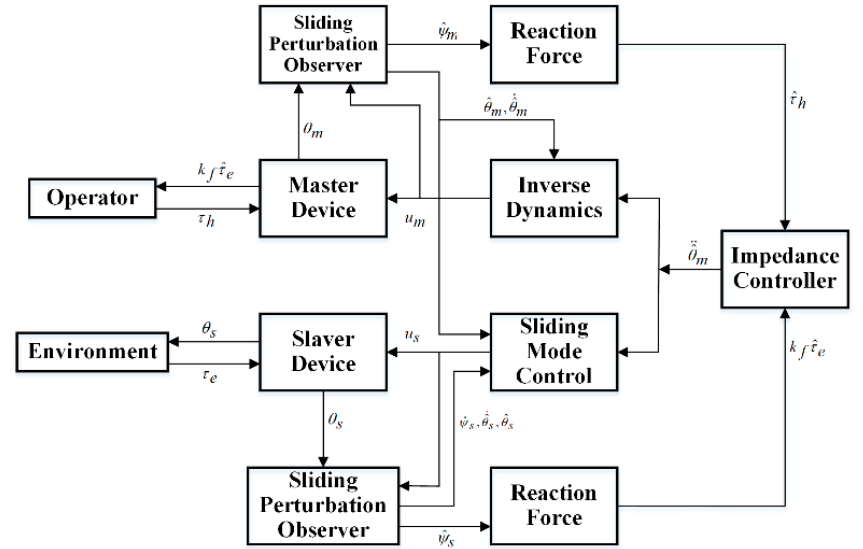
Figure 5. The work flow of control algorithm.